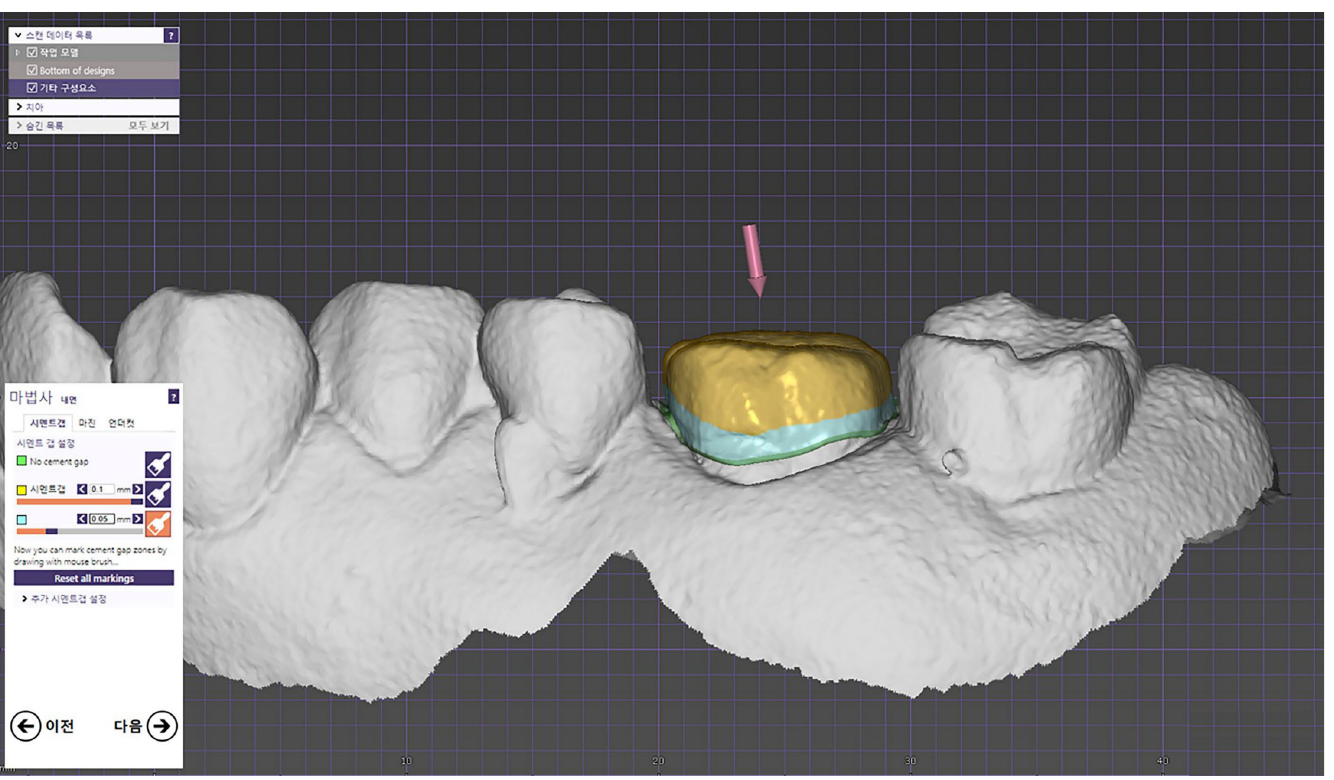
Fig 8. Computer-aided design for the interim